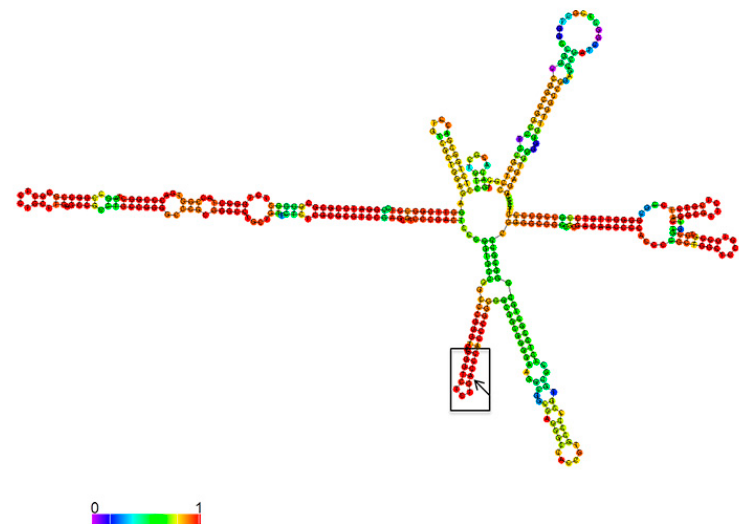
Figure 4. Predicted secondary structure of the first 415 bp of 5 ′‐ ETS in 47S pre ‐ rRNA. Black square marks the helix with adenosine 196 (pointed by black arrow).